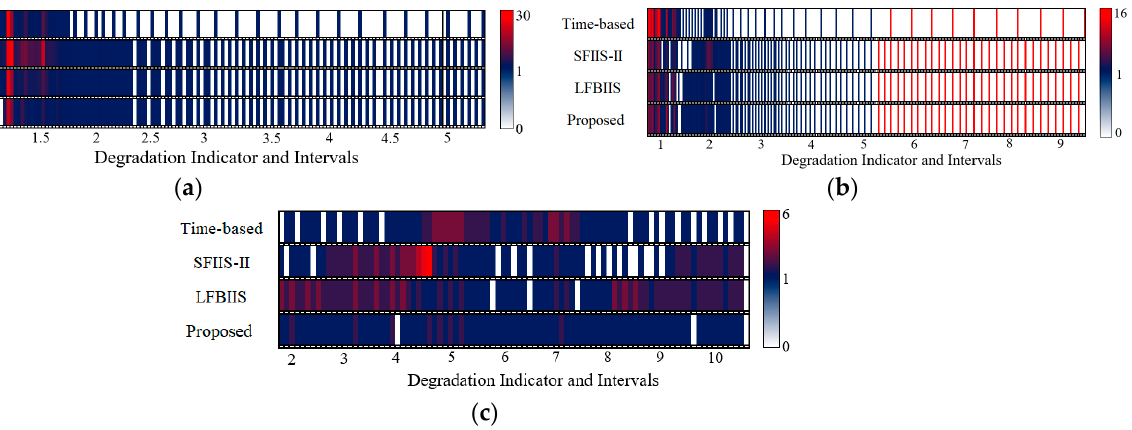
Figure 10. The distribution of sampled data from real bearing data. ( a ) Bearing 1_1; ( b ) Bearing 1_3; ( c ) Bearing 1_4.